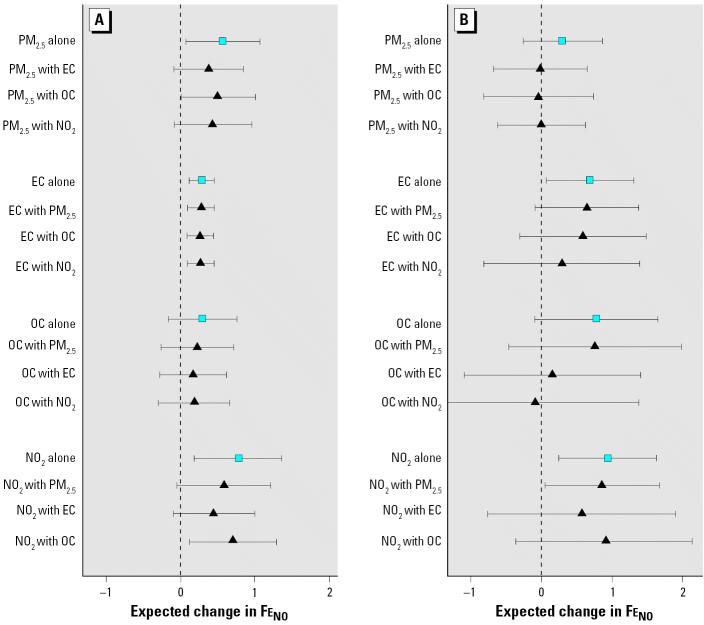
One- and two-pollutant models for change in FeNO using 2-day MA personal (A) and central-site (B) pollutant measurements. Squares: single-pollutant model; triangles: two-pollutants models. Expected change in FeNO is per IQR in the pollutant of interest with 95% CIs. All estimates are adjusted for personal temperature and relative humidity.